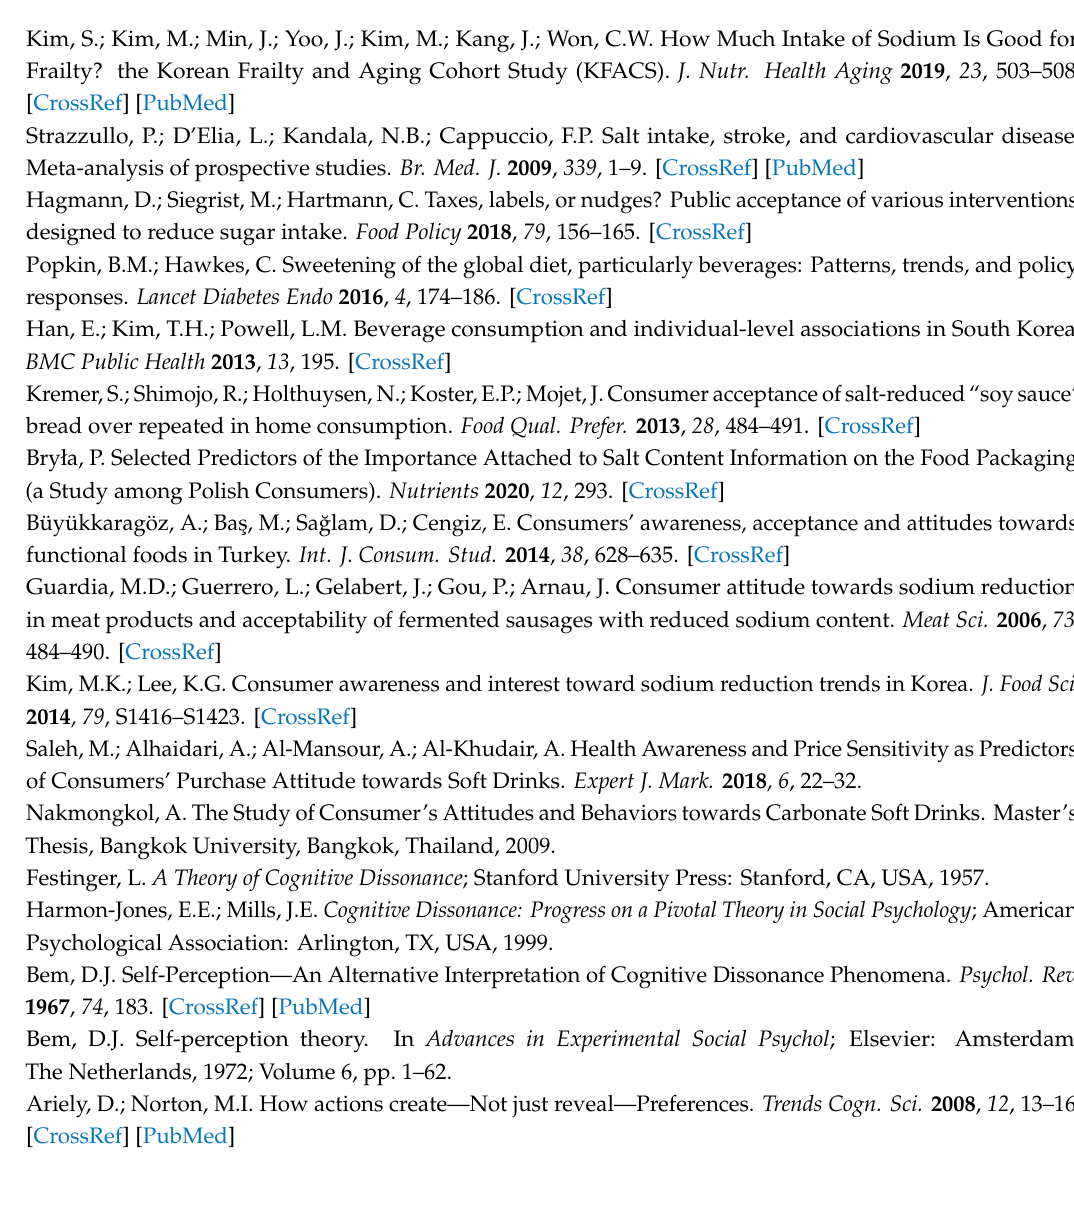
Figure A2. Yogurt products used as stimuli in the survey.